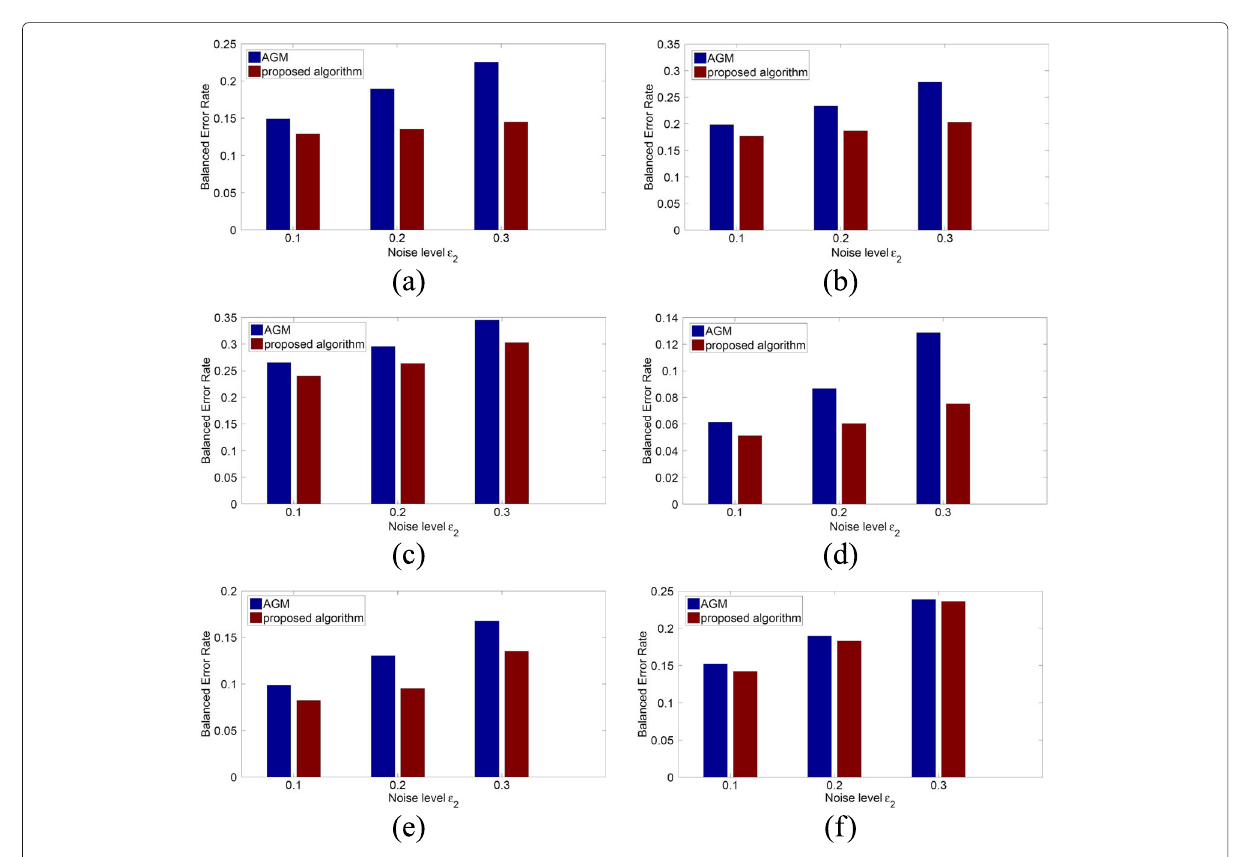
Fig. 4 Comparison between the proposed noise-aware game-theoretic community detection algorithm and the AGM method in [15]. a η = 0.1, K = 2; b η = 0.2, K = 2; c η = 0.3, K = 2; d η = 0.1, K = 3; e η = 0.2, K = 3; f η = 0.3, K =